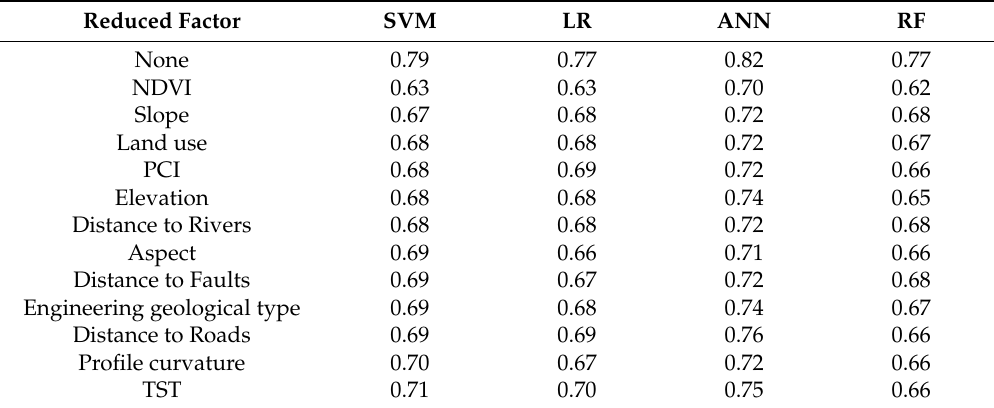
Table 5. The AUC values of the models with different reduced landslide-causing